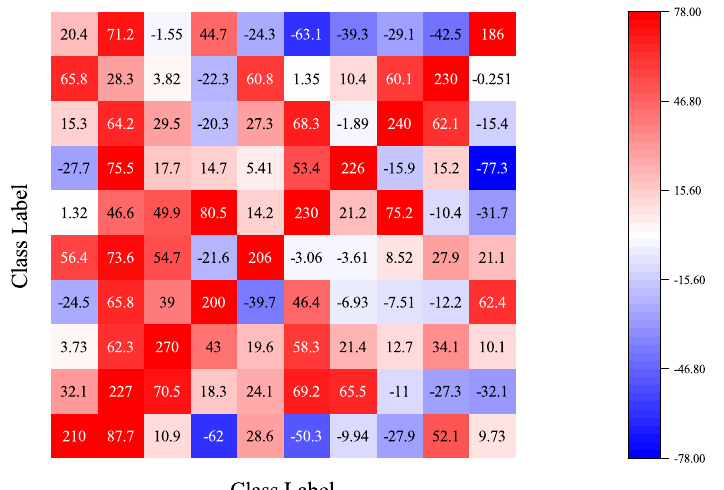
Figure 5. A heat-map visualization of the relationship matrix of a backdoor model poisoned by the BadNet attack method. The target attack class is class 1. As shown in the figure, the features of class 1 show an abnormal cooperative relationship with features of other